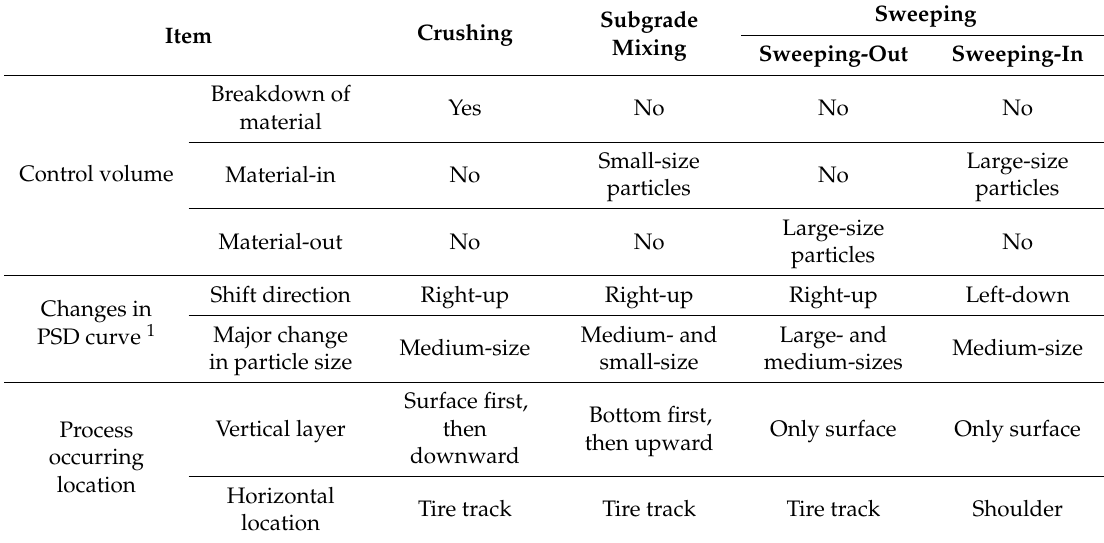
Table 1. Modeling tra ffi c-induced processes and their e ff ects on forest road aggregate particle size